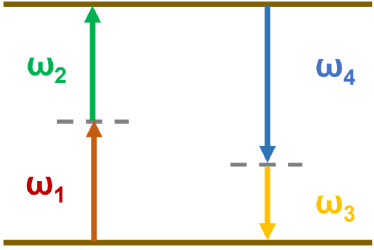
Figure 2. Schematic of a FWM process.